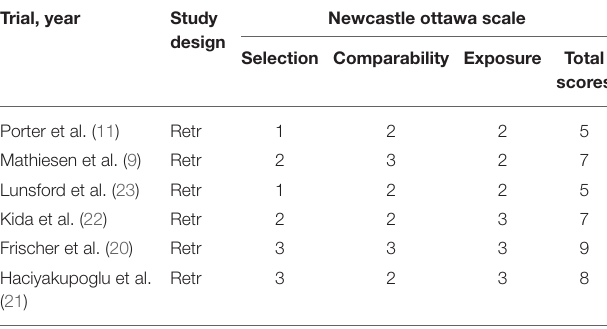
TABLE 3 | Newcastle Ottawa Scale (NOS) quality assessment of final article